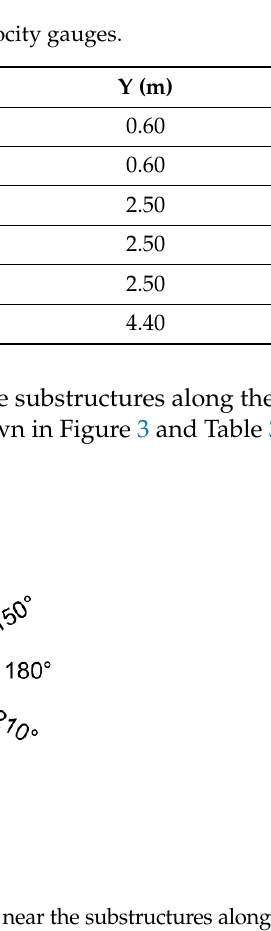
Figure 3. Schematic representation of the gauges near the substructures along the z direction every 30 ◦ . The velocity and dynamic pressure were measured near the vertical cylindrical sub- structures every 30 ◦ . The details of the measuring positions are shown in Table 4. height was H = 1.3 m, and the depth of the water was d = 3.8 m. In Table 5, all